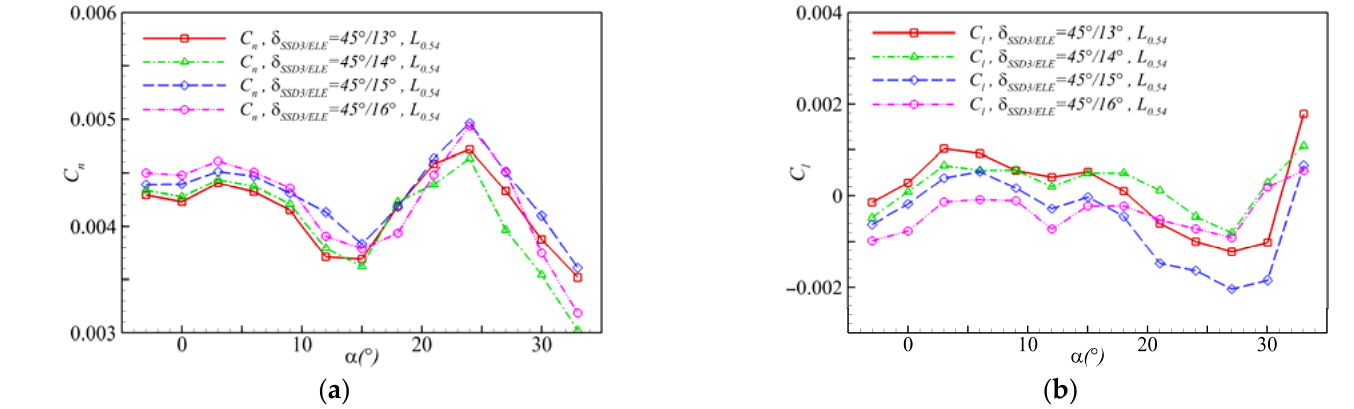
Figure 17. Control characteristics of the FCRs with different collocating deflection angles, Ma = 0.2, Re = 3.98 × 10 7 : ( a ) Yawing moment; ( b ) Rolling moment.